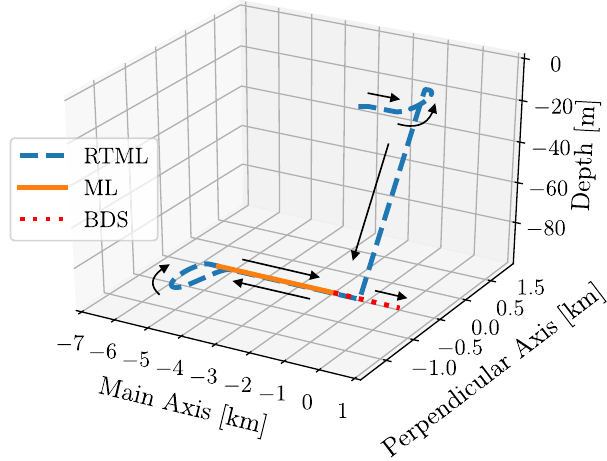
FIG. 2. Geometry of the electron beamline of CLIC at 380 GeV. Main and perpendicular axis vs depth: RTML (dashed blue), ML (solid orange) and BDS (dotted red). The black arrows show the direction of the beam. The IP is at